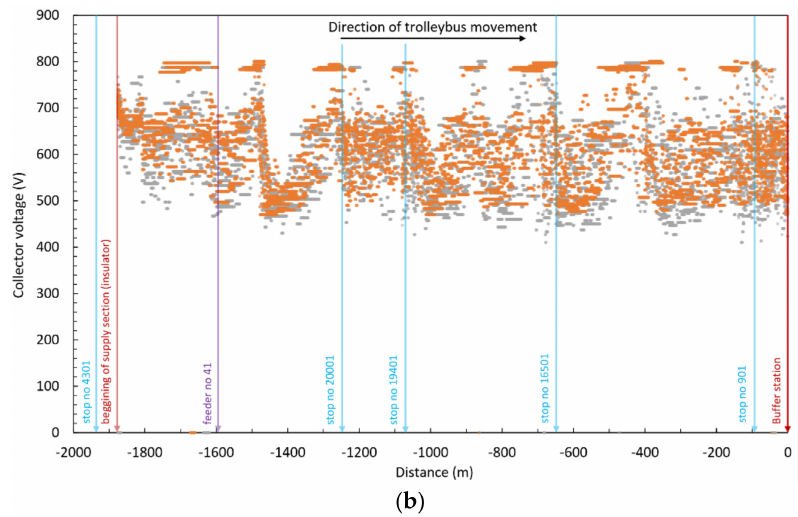
Figure 6. Trolleybus pantograph voltage in function of distance from BS for inactive BS (gray) an active BS (orange) recorder by 10 northbound trolleybuses ( a ) and 10 southbound trolleybuses ( b ).